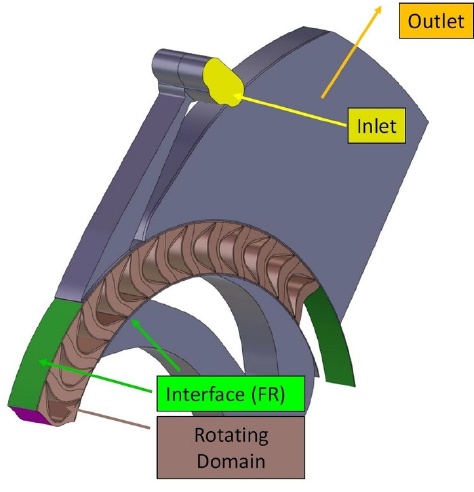
Figure 5. Simulation model of the Elektra turbine.